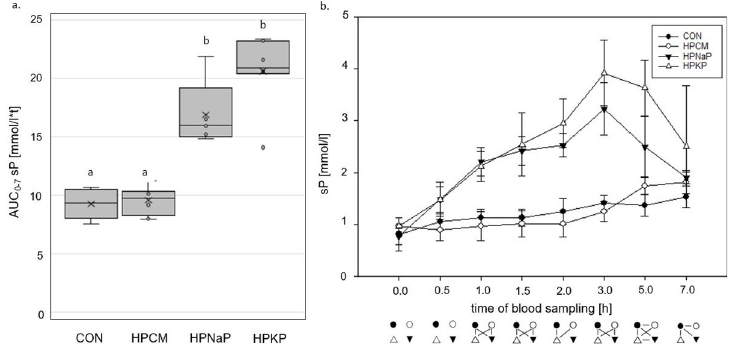
Fig 1. Serum P (sP) concentrations. a. Area under the curve from 0 until 7 hours postprandially (AUC 0-7 ) of sP [mmol/l � t] in adult dogs fed a control diet and 3 different high P diets for 18 days. Boxes not sharing a superscript letter are significantly different (p < 0.05) b. Kinetics from 0 to 7 hours postprandially of sP [mmol/l] in adult dogs fed a control and 3 different high P diets. Connected symbols below the graph are significantly different (p < 0.05) at the corresponding time point. Reference range for healthy adult dogs: 0.7–1.6 mmol/l [85].